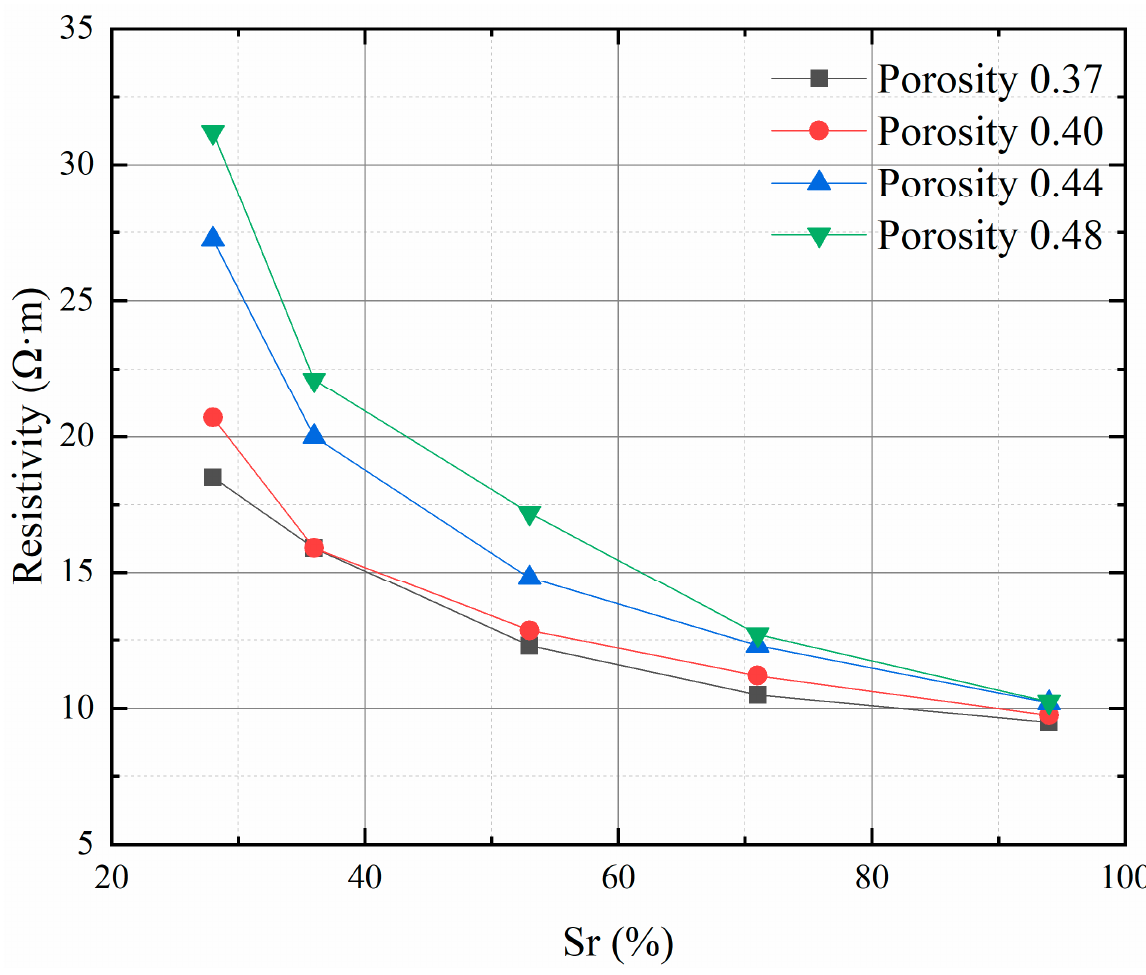
Figure 3. Variation in soil resistivity with saturation.